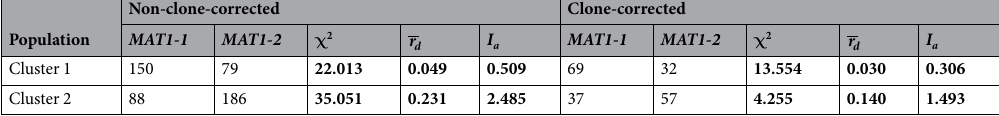
Table 7. Tests of linkage equilibrium of microsatellite loci and mating-type frequencies for two Cercospora beticola clusters detected through Bayesian clustering using the software STRUCTURE. Significant values ( P < 0.05) are indicated in